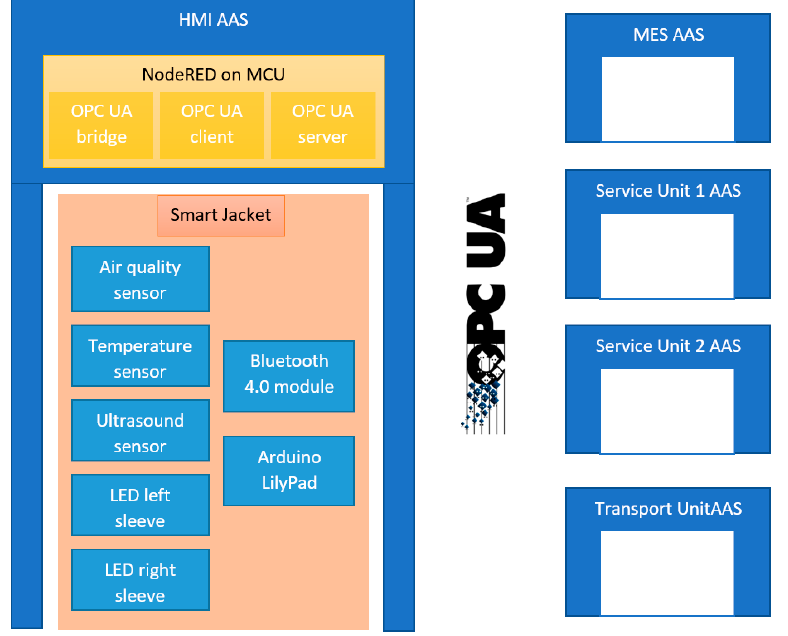
Figure 9. A SmartJacket operator represented via the HMI.